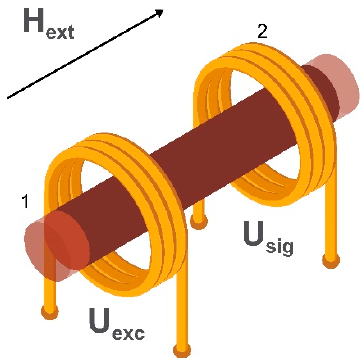
Figure 12. Schematic image of the sensing element of the magnetoelastic material-based strain sensor where an applied magnetic field generated by an alternating voltage U exc in a primary coil (1) causes an alternating voltage U sig induced in a secondary ‘detection’ coil